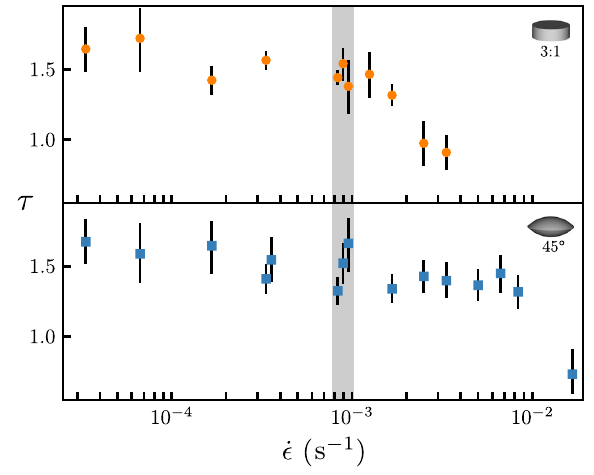
FIG. 7. Strain rate dependence of τ . Uncertainties are calculated as before with the bootstrap method. The gray region contains the points which were taken at the same strain rate as the rest of the paper, _ ϵ ¼ 8 × 10 − 4 . These points for both particle shapes and the _ ϵ ¼ 3 × 10 − 4 data for the lenses are offset slightly to display multiple sets of runs taken at the same strain